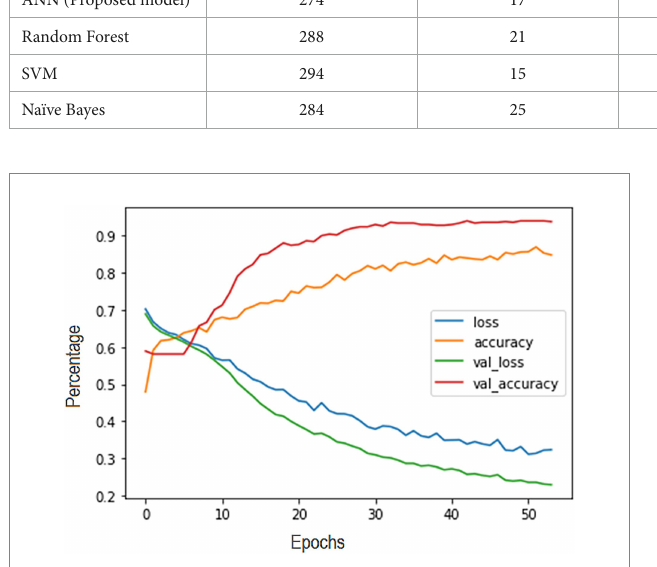
FIGURE 8 Accuracy and loss recorded for each